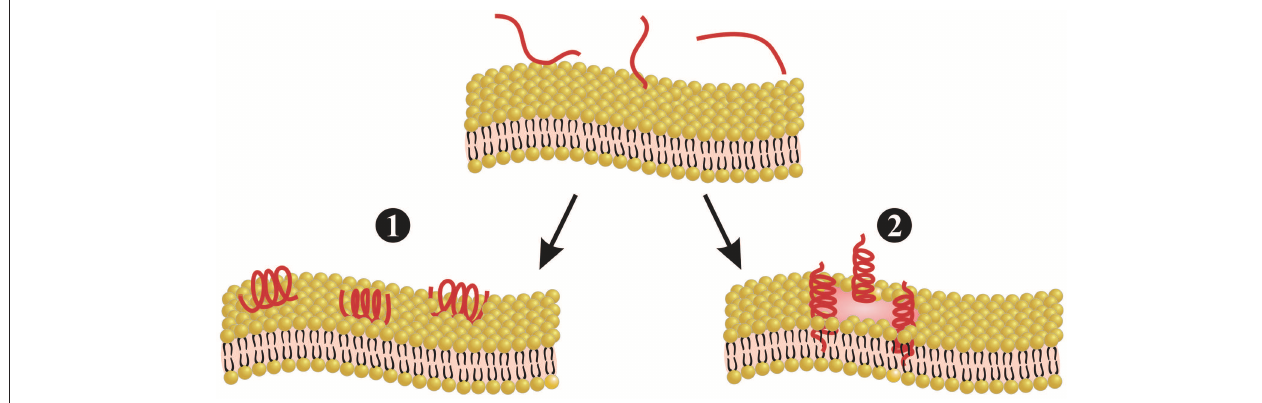
FIGURE 3 | Melittin-induced pore formation model. Melittin can bind to the membrane either in a parallel orientation (1) or a perpendicular orientation (2). The perpendicular orientation induces pore formation, whereas the parallel orientation is inactive. Parallel orientation has also been hypothesized to protect the membrane, since this prevents other melittin molecules from forming pores. Figure adapted from van den Bogaart et al. (90).